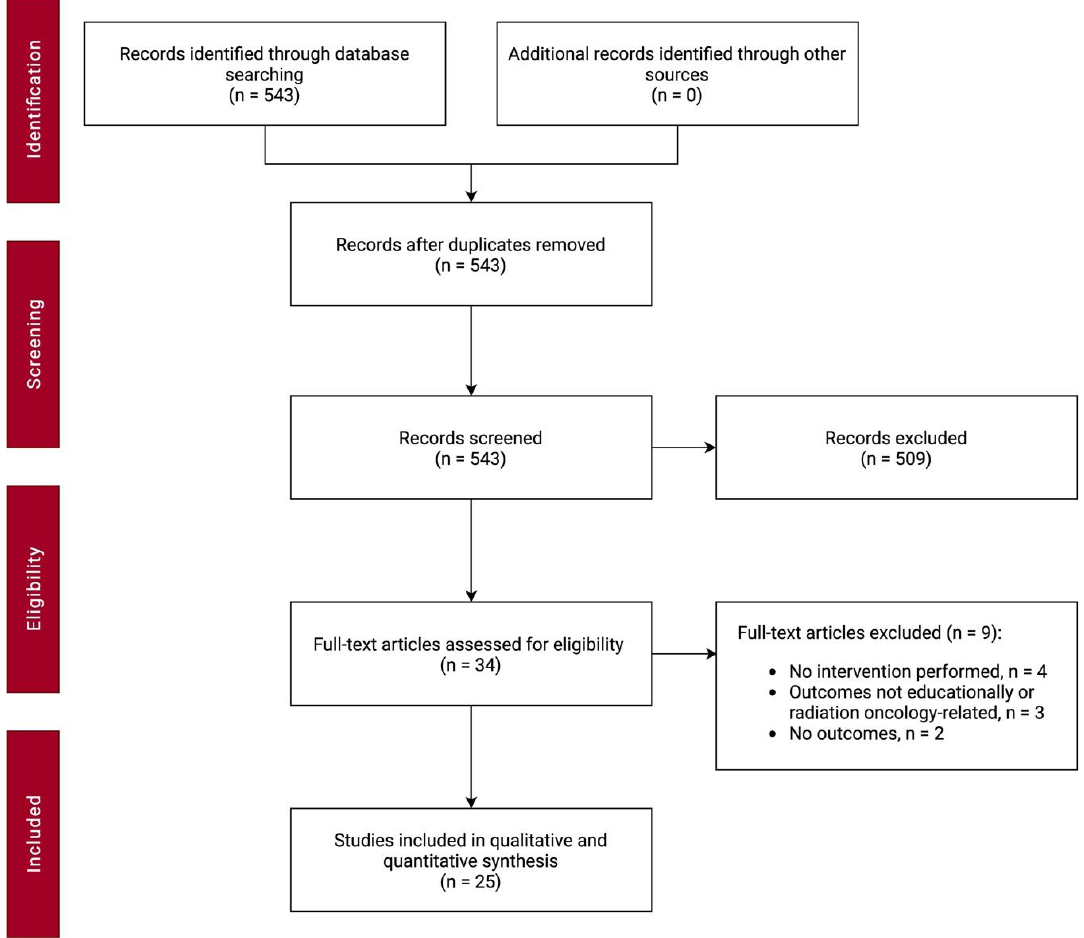
Figure 1. Preferred reporting items for systematic reviews and meta-analyses (PRISMA) flow diagram.